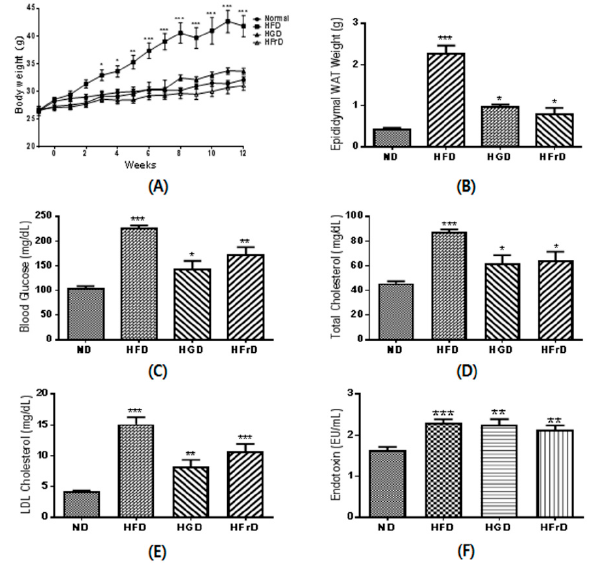
Figure 1. Metabolic disorder parameters in high-glucose diet (HGD) or high-fructose diet (HFrD) fed mice. ( A ) body weight changes during the 12 weeks of feeding; ( B ) white adipose tissue (WAT) weight; ( C ) fasting blood glucose; ( D ) serum total cholesterol; ( E ) serum low-density lipoprotein